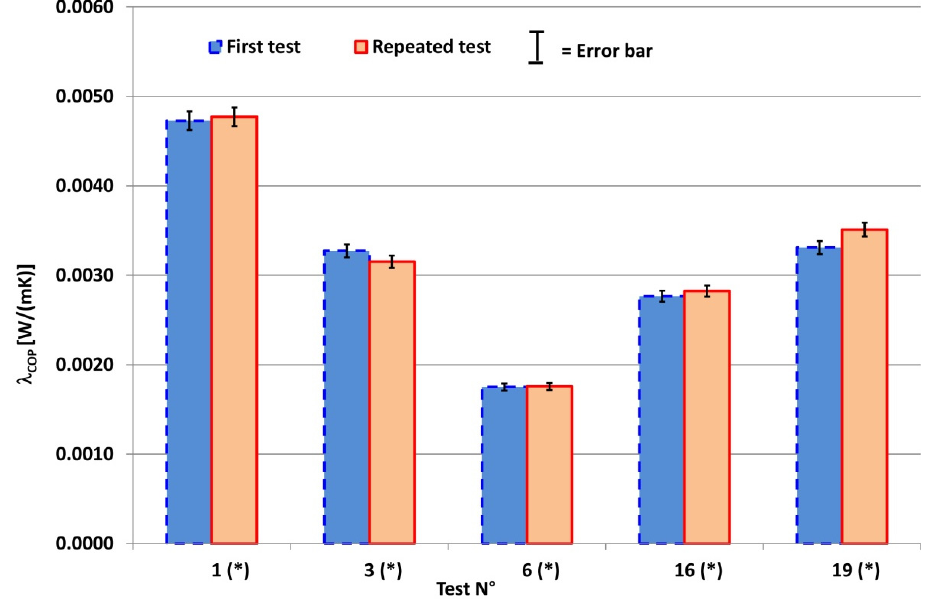
Figure 1. Repeatability of measurements—Results from repeated tests on the same sample— λ COP